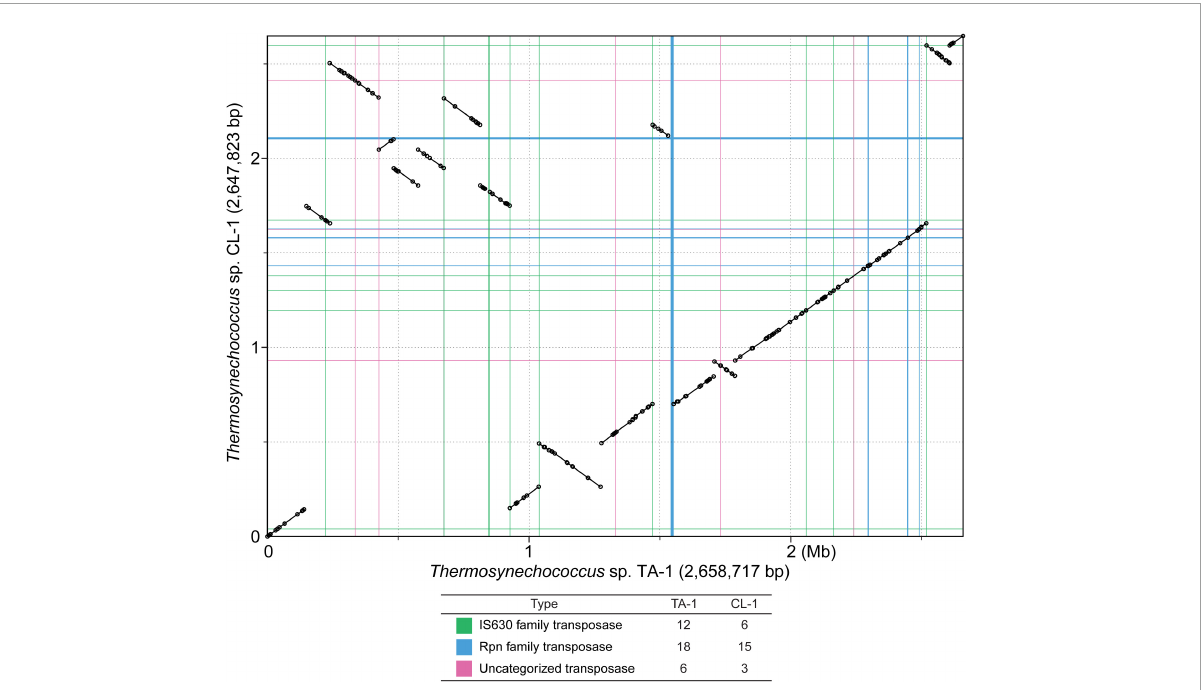
FIGURE2 Genome alignment between two Thermosynechococcus strains collected in Taiwan. The circular chromosomes are plotted in linear form to illustrate syntenic regions. Positions of putative transposase genes are plotted using colored lines to illustrate the correspondence with synteny breakpoints. Counts of putative transposase genes are provided below the synteny plot. The locations and counts include intact transposase genes listed in the GenBank annotation ( Table 1 ), as well as un-annotated fragments that were identified by TBLASTN searches (see section “materials and